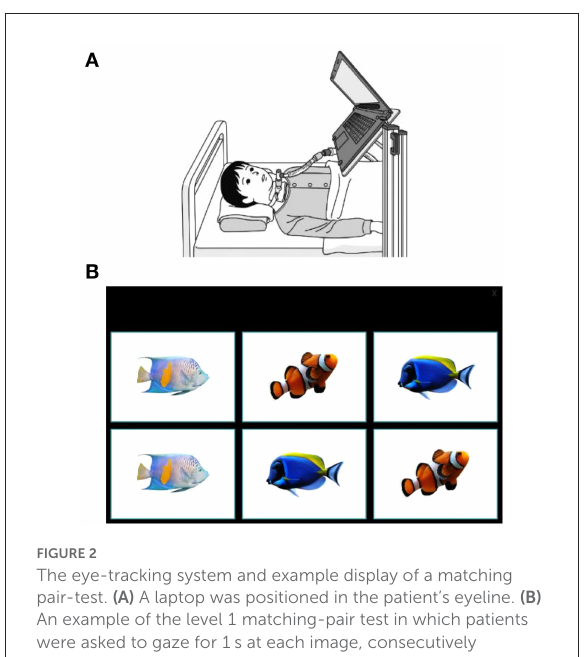
FIGURE2 The eye-tracking system and example display of a matching pair-test. (A) A laptop was positioned in the patient’s eyeline. (B) An example of the level 1 matching-pair test in which patients were asked to gaze for 1s at each image, consecutively identifying matching pairs. The eye-tracking device at the base of the laptop screen captured data on eye